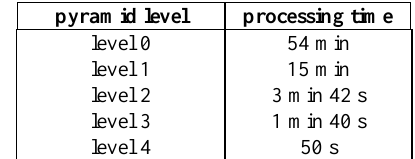
Figure 3. Differential DSM for test area Kamionek for years 2017-2018 Table 1. The relationship between the image pyramid level and the matching processing time for test area